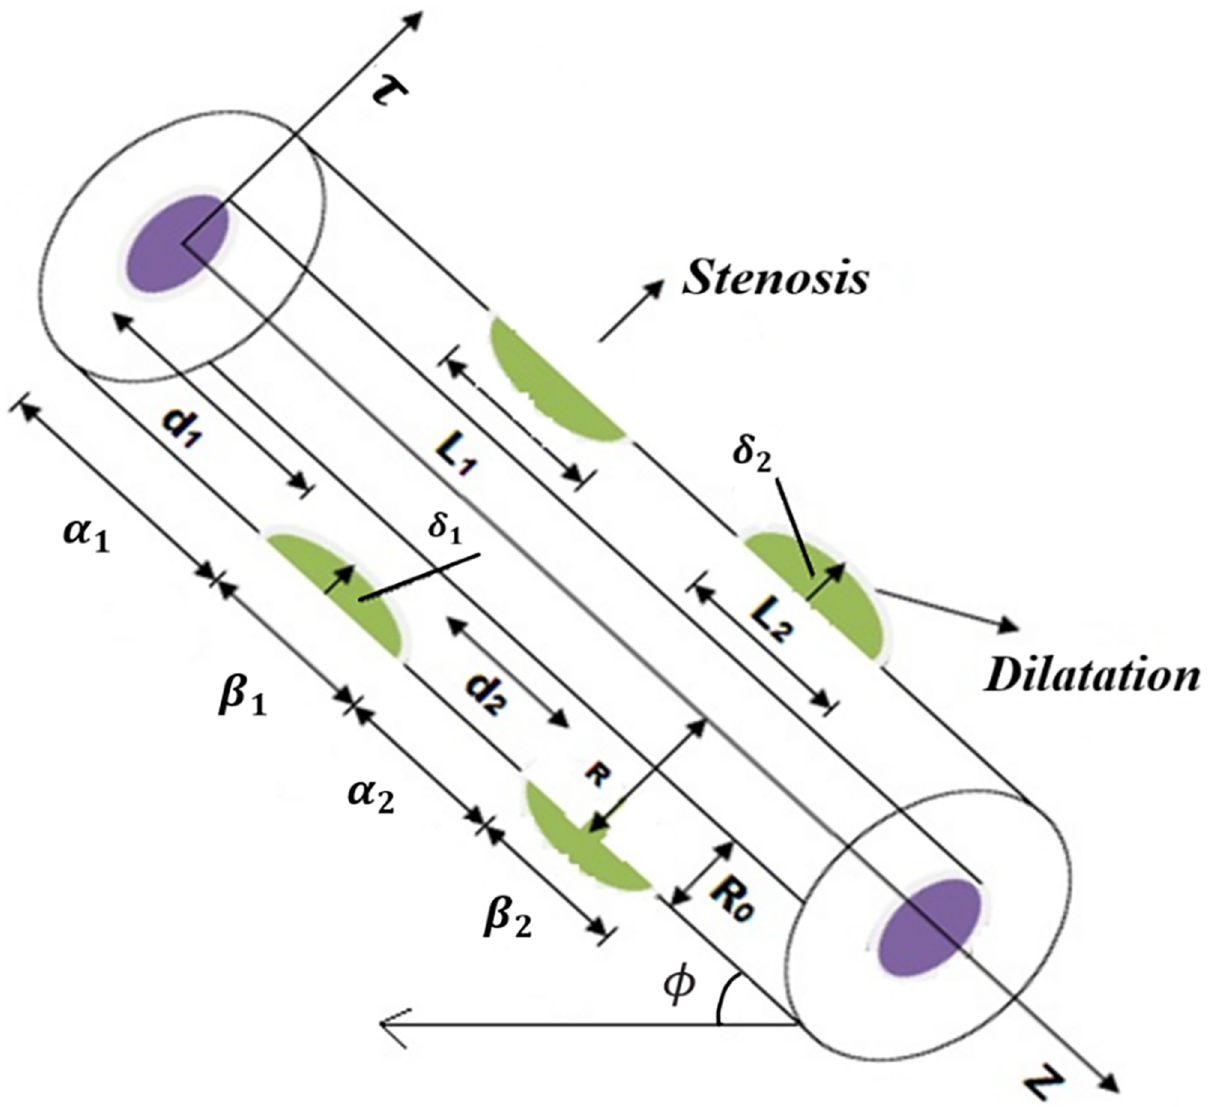
Fig 1. A plot of a stenotic